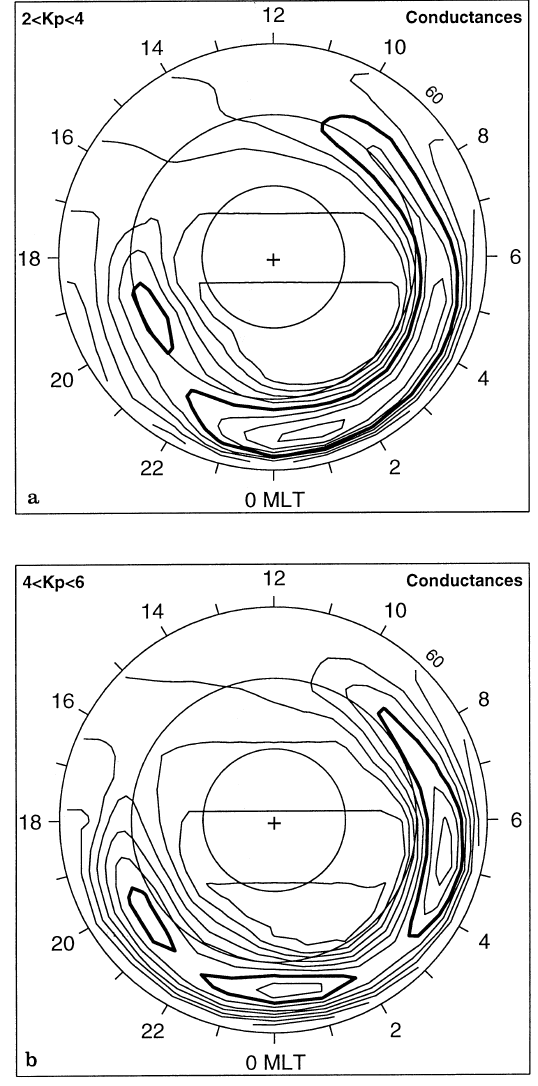
Fig. 1a,b. Isocontours of Hall conductances represented in polar maps between the north pole and 60 (cid:176) invariant latitude, with the MLT indicated on the external circle . The contour interval is 2 mhos and the bold line corresponds a to 10 mhos for 2 < Kp < 4 and b to 13 mhos for 4 < Kp